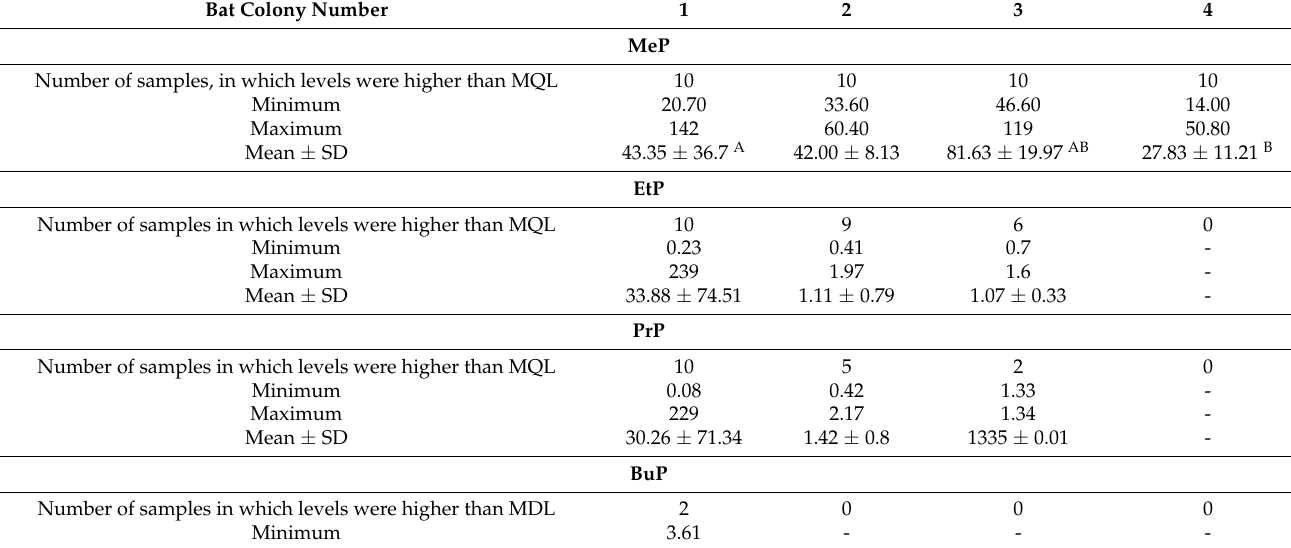
Table 4. Concentration values (ng/g dw.) and frequency of detection of parabens and bisphenol A in the analyzed guano samples taking into account the place of